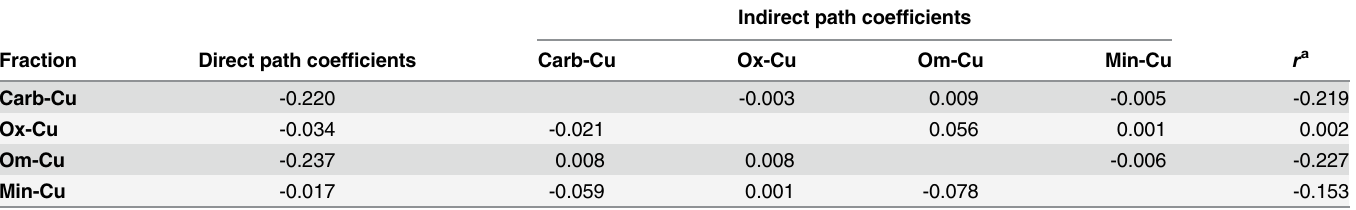
Table 2. Path and correlation coefficients of Cu fractions to DTPA-Cu. Carb-Cu, carbonate-bound Cu; Ox-Cu, oxide-bound Cu; Om-Cu, organic-matter- bound Cu; and Min-Cu, mineral-bound